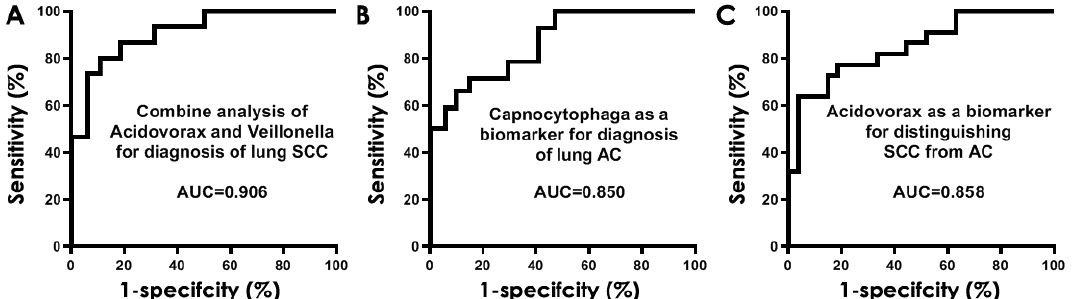
Figure 4. Receiver-operator characteristic (ROC) curve analysis of abundances of bacterial genera in sputum of cohort 1 comprising NSCLC patients and cancer-free controls. The area under the ROC curve (AUC) for bacterial genera conveys its accuracy for diagnosis and classification of NSCLC. ( A ) The combined use of Acidovorax and Veillonella produced 0.91 AUC. ( B ) The use of Capnocytophaga as a sputum biomarker could detect lung AC with 0.85 AUC. ( C ) The use of Acidovorax as a sputum biomarker had 0.85 AUC for differentiating between SCC and SC of the lungs.